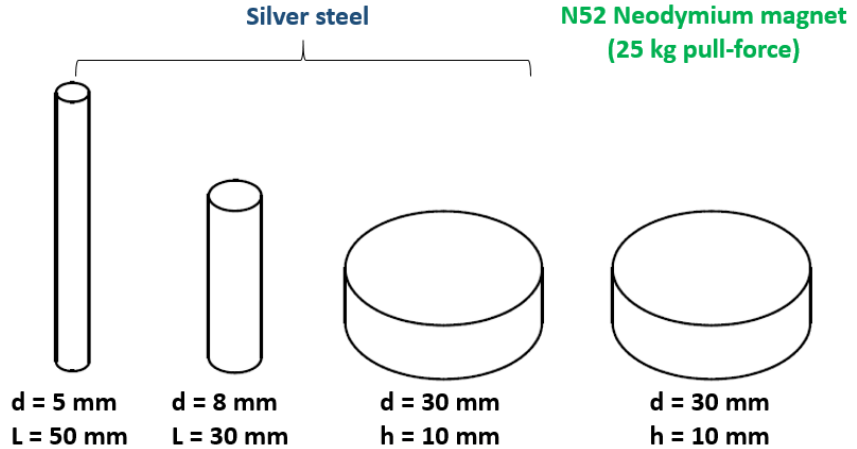
Figure 7. The chosen shapes, sizes, and two different magnetic materials used in this experiment against a 45 kg pull-force neodymium magnet.